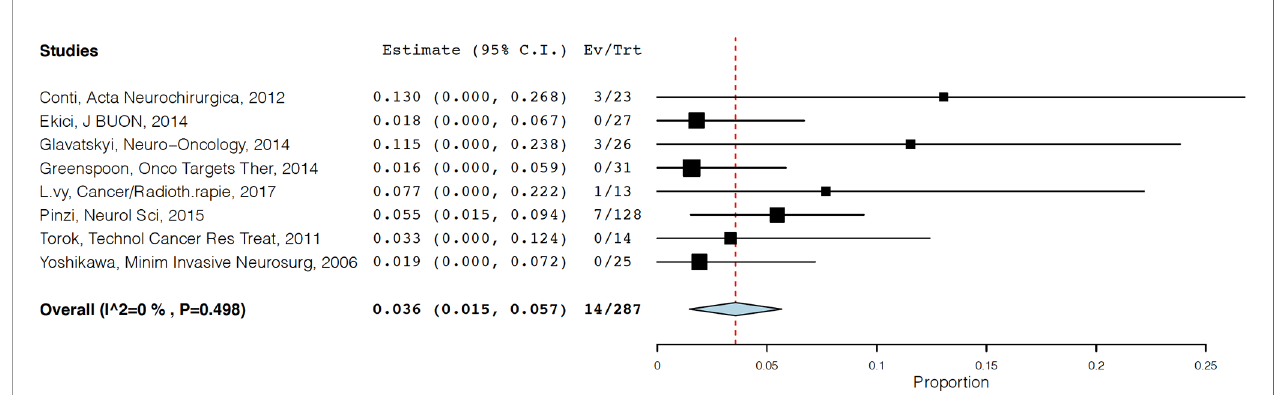
FIGURE 3 | Forest plot showing rates of acute neurological side effects following CK